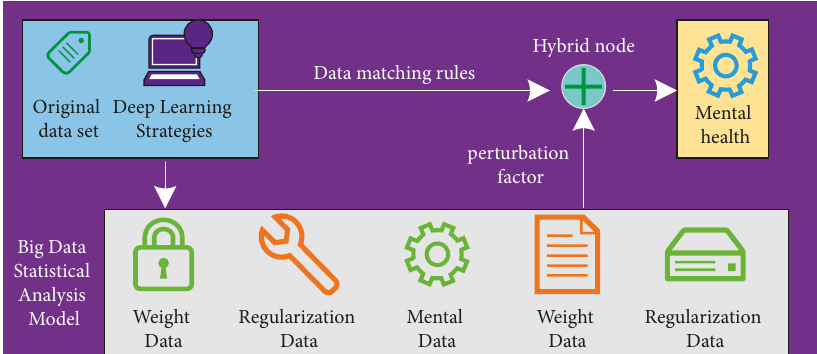
Figure 1: The construction process of the application model of deep learning in the analysis and evaluation of college students’ mental